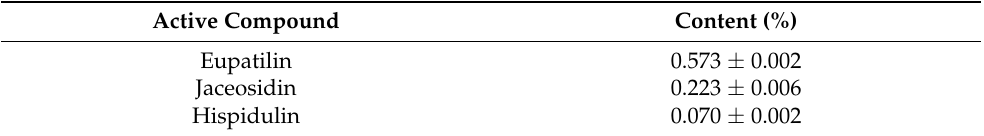
Table 2. Contents of representative compounds in RW0117.